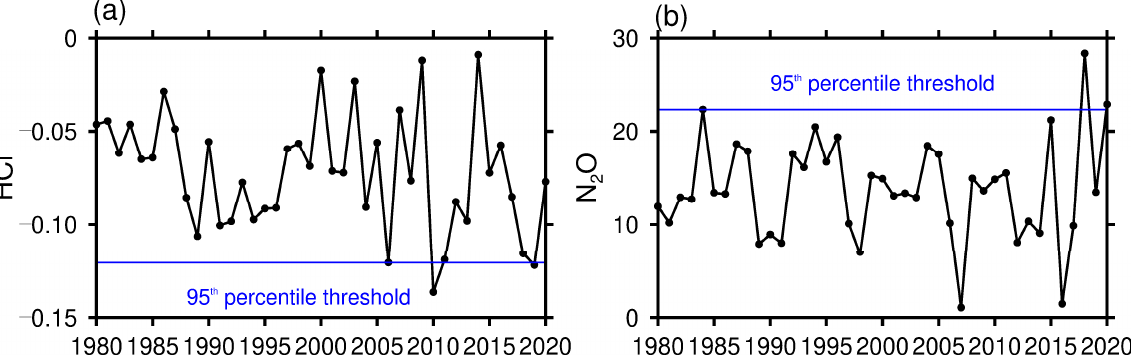
Figure 10. Variations in ( a ) HCl and ( b ) N 2 O gradient from 1980 to 2020 based on SLIMCAT model simulation. The HCl (N 2 O) gradient was calculated using the minimum value of HCl (maximum value of N 2 O) in a year minus the maximum (minimum) value in the past 12 months.